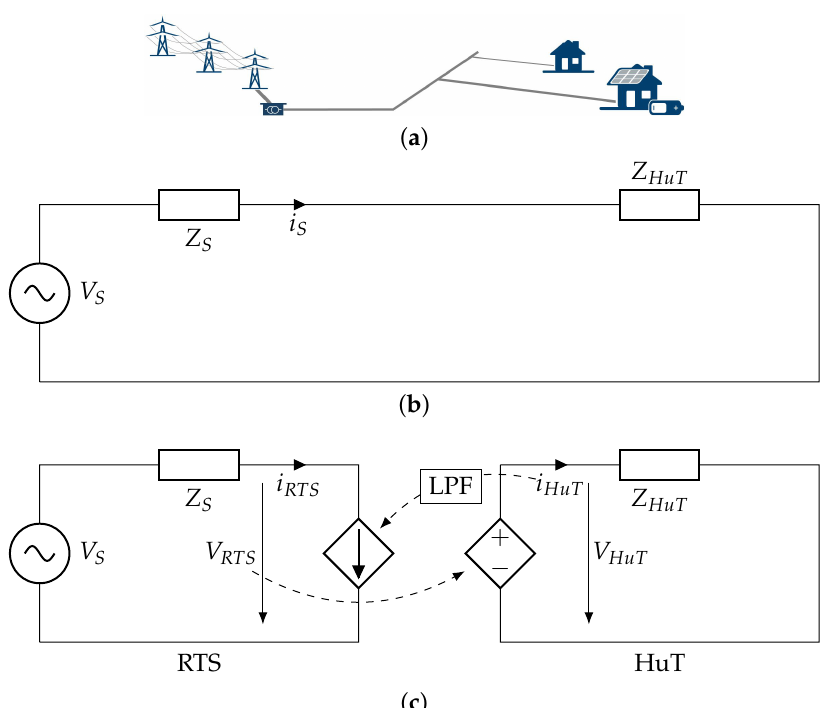
Figure 7. Exemplary low-voltage grid reduced to a minimal PHiL circuit with voltage-type ITM IA ( a ) Exemplary low-voltage grid; ( b ) Simplified equivalent circuit of the low-voltage grid; ( c ) Equiva- lent circuit with voltage-type ITM IA.